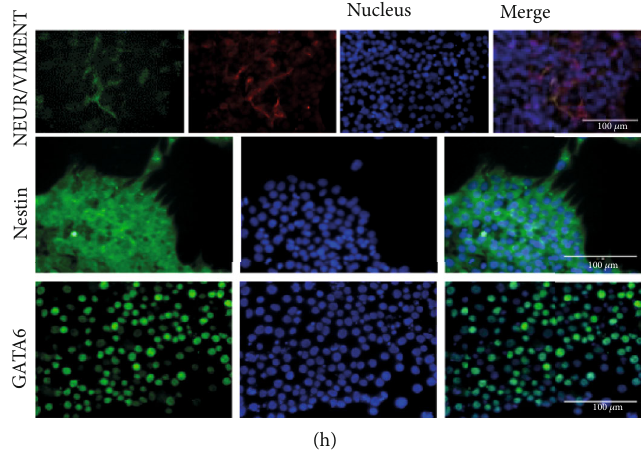
Figure 3: (a – c) Embryoid body (EB) formation from groups H, HL, and L, respectively. (d, e) RT-PCR results for ectoderm gene β III-tubulin ( β III Tub), endoderm gene alpha-fetoprotein (AFP), and mesoderm gene bone morphogenetic protein (BMP4) and for the expression of the lentiviral vector (hOSKM) and housekeeping gene PPIA in embryoid bodies (EB, d, left) and spontaneous di ff erentiation (SD, d, right), from groups H, L, and HL; in eiPSC cells from groups H, HL (e, fi rst row left and right, respectively), and L (second row) and fi broblast (third row) cultured in high (FH, left) and low (FL, right) oxygen. (f – h) Immunocytochemistry of spontaneous di ff erentiation for mesoderm marker vimentin, ectoderm markers nestin and neuro fi lament, and endoderm marker GATA6, in groups H (f), HL (g), and L (h). Scale bars: 100 μ m and 200 μ